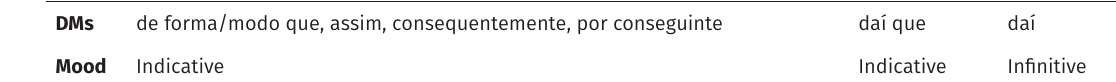
Table 2: Mood distribution and consequential DMs in